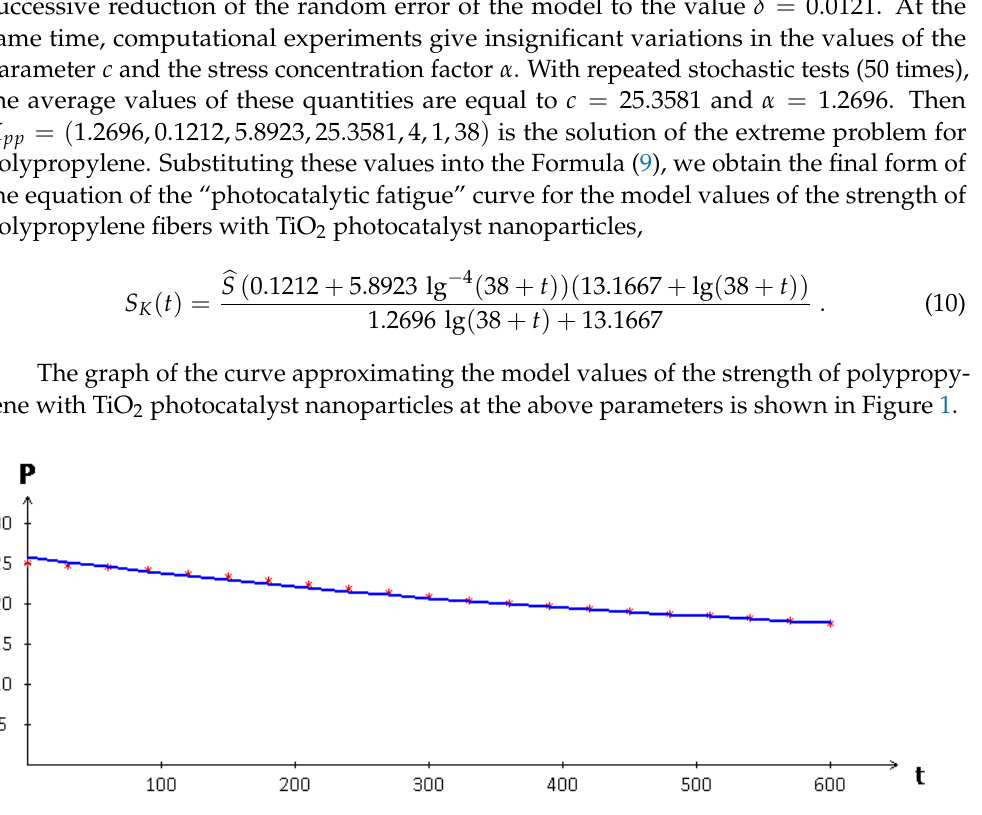
Figure 1. Ultimate tensile strength (ordinate in Newtons) of polypropylene fibers with TiO 2 photo- catalyst nanoparticles as a function of irradiation time (abscissa in minutes). The asterisks on the graph are the model data, and the curved line is the results of the approximation of the model data by Equation (10), whose coefficients are obtained by the Monte Carlo